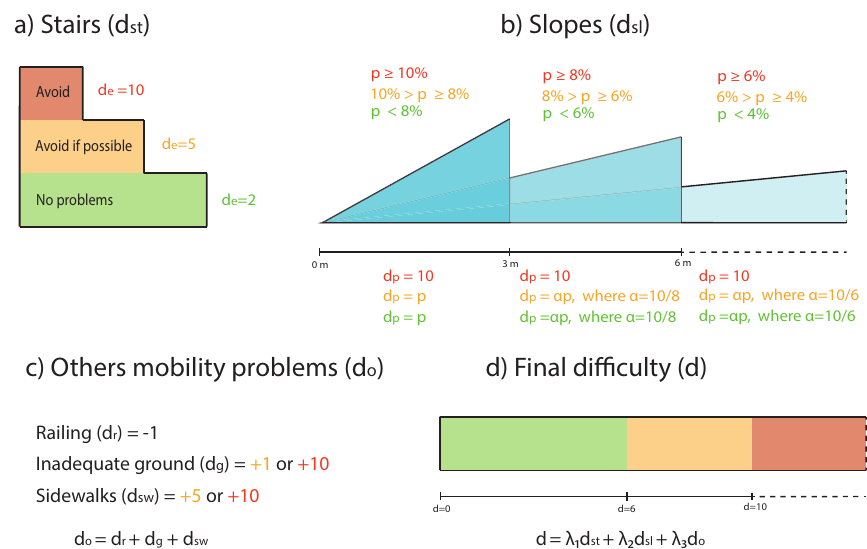
Figure 1. Accessibility scheme: Calculation of the difficulty of a